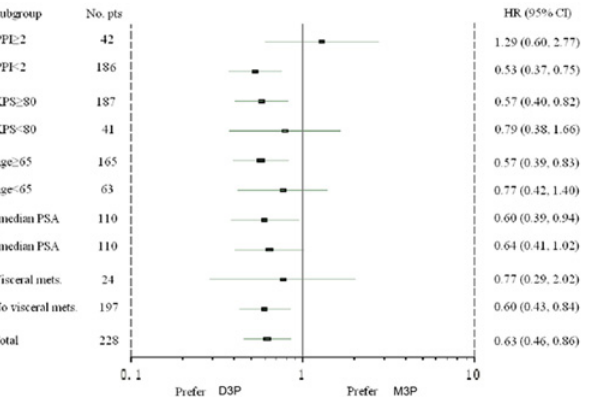
Figure 3. The primary analysis on overall survival in subgroups. Patients in D3P arm and M3P arm were divided into subgroups by stratification variables (baseline PPI and KPS) and prognostic factors of interest (age, baseline PSA and visceral involvement). There were no statistically difference between two arms in subsets of PPI (cid:1) 2, KPS (cid:1) 80, median PSA < 110ng/ml and visceral metastasis, and subgroup analysis showed favorable results for D3P arm in the rest of subsets. PPI = present pain intensity; KPS = Karnofsky performance status; PSA = prostate specific antigen; visceral mets. = visceral